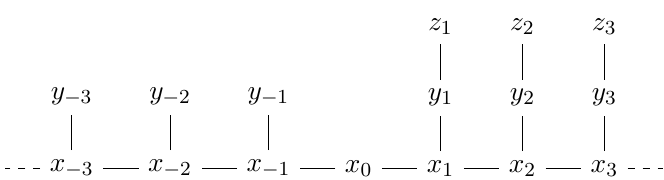
Fig. 2. The graph Γ from Example 4.7.